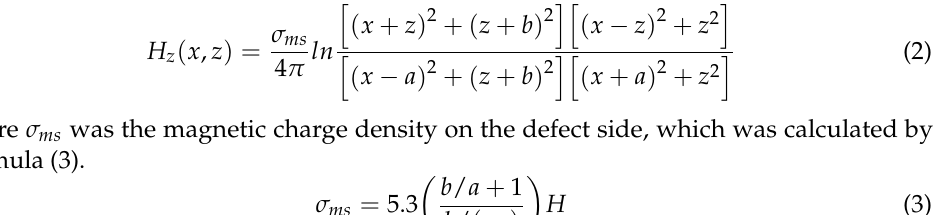
Figure 5. Magnetic fl ux leakage simulation model. Set the sensor lift-o ff to 1 mm, defect width to 0.2 mm, defect depth to 1.0, 1.5, 2.0, 2.7, 3.0, 3.5 and 4.5 mm and motion range to − 25~25 mm. The simulation results of the Bx and Bz direction signals are shown in Figures 6 and 7.